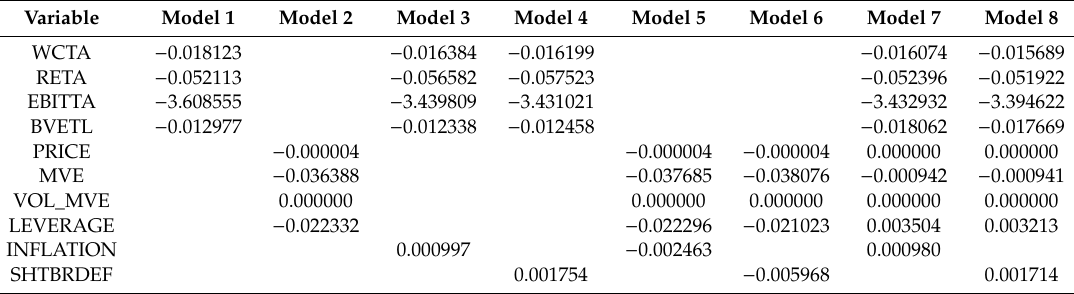
Table A4. Marginal e ff ect post crisis,